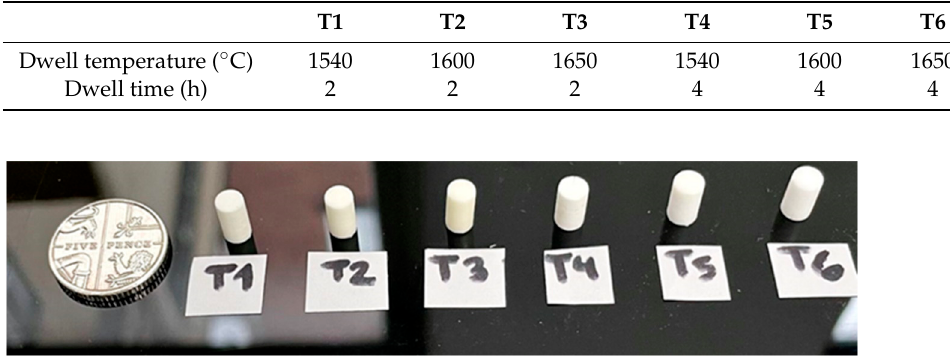
Figure 2. Sintered samples resulting from the different sintering trials.